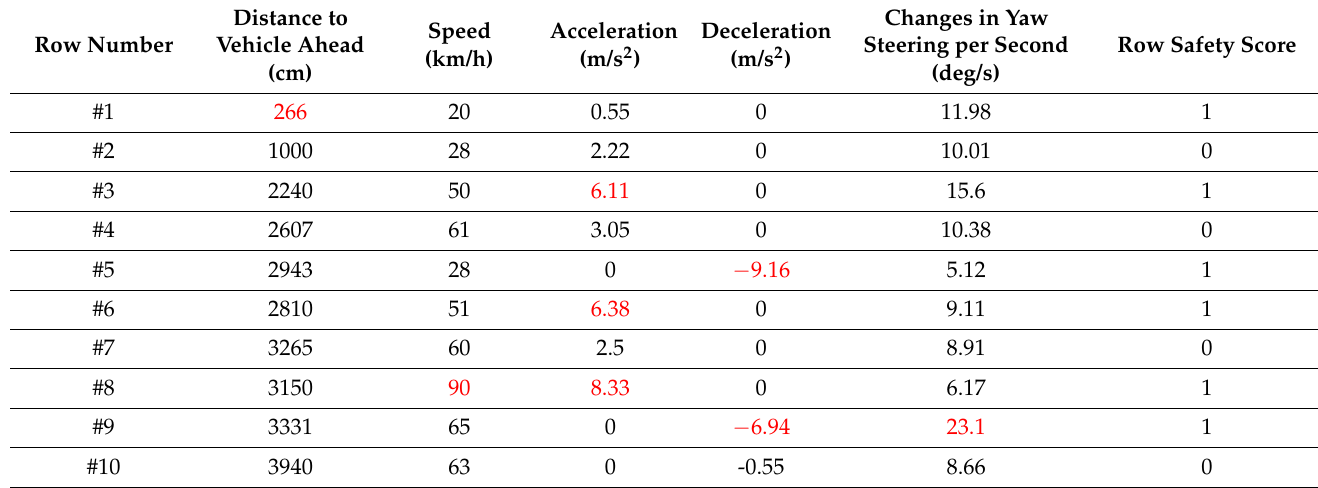
Table 4. Demonstration of the row labeling